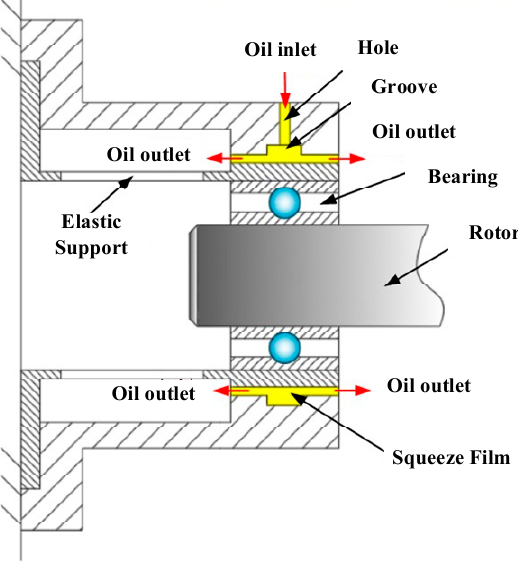
Figure 1. Structure schematic of a bearing with SFD.